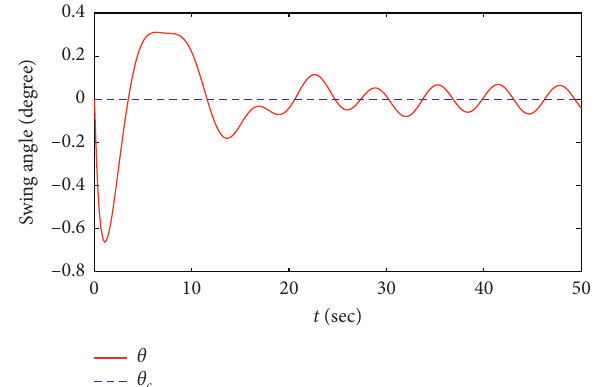
Figure 3: The tracking control result of the swing angle of hanging load θ .